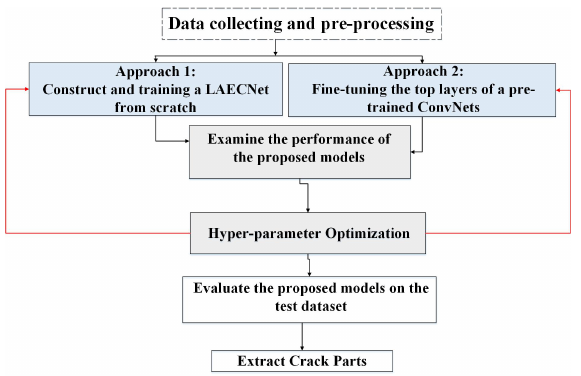
Figure 1. Workflow of the recommended